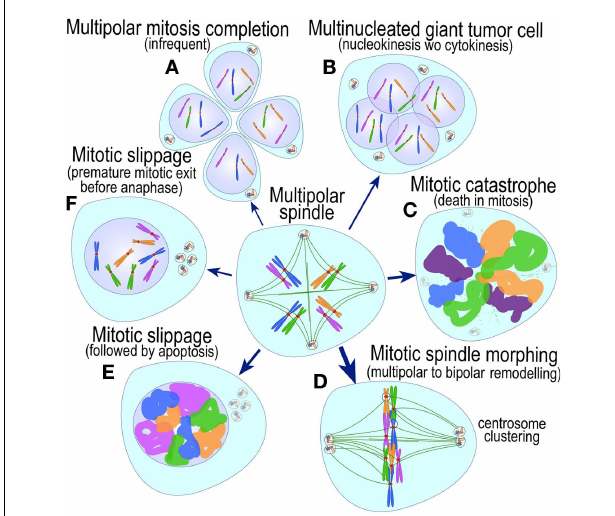
FIGURE 5 | Possible outcomes of multipolar mitoses in cancer . A subset of cells with multipolar spindles carry mitosis to completion, resulting in highly aneuploidy cells, some with abnormal centrosome number (A) . Others fail cytokinesis resulting in giant multinucleated polyploid cells, often with supernumerary centrosomes (B) . Some cells exit mitosis in a process termed “mitotic slippage” and become polyploid cells with supernumerary centrosomes (F) , or apoptose in the subsequent G1 phase (E) .Yet others undergo mitotic catastrophe (death in mitosis) (C) . Finally, most cells with multipolar mitosis, after significant delay, reconfigure their multipolar spindles into bipolar spindles resulting in (mostly) normal or abnormal (merothelic, synthelic chromosome) chromosome segregation (D) .The thickness of the arrows in the figure intends to provide an estimate of the frequency of these events in cancer cells.